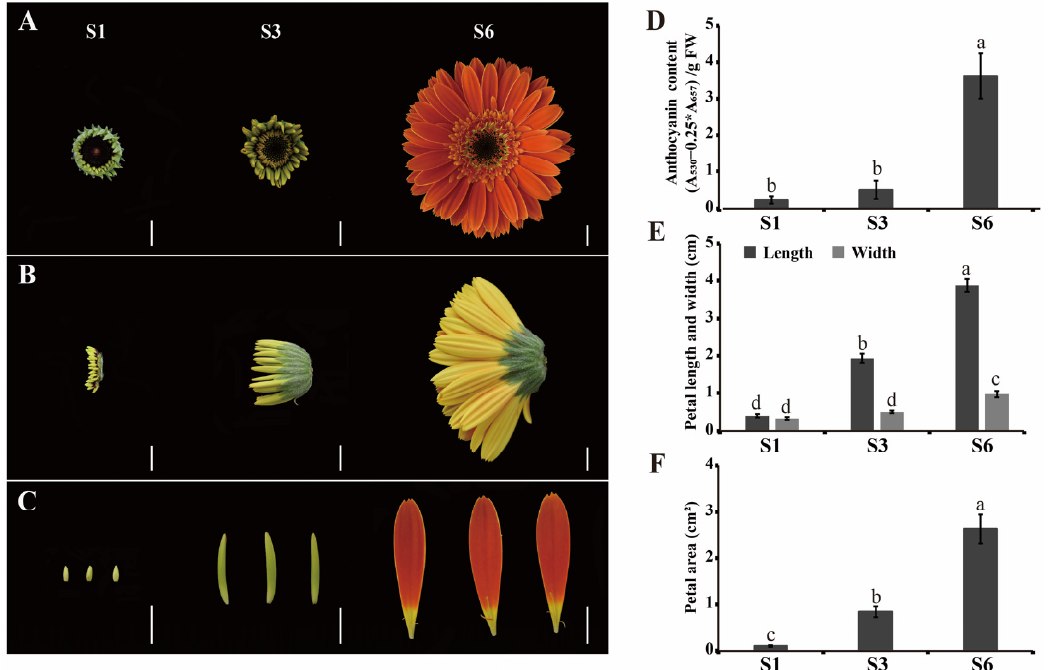
Figure 1. Morphological features of ray florets at different growth and development stages. ( A – C ), Front ( A ) and side ( B ) view of inflorescence, and ray florets ( C ) of gerbera at different stages. Scale bar = 1 cm. ( D – F ), The anthocyanin contents ( D ), length and width ( E ), and area ( F ) of ray petals at different stages. FW: fresh weight. Statistical significance is indicated by different letters ( p < 0.05). Values represent means of n = 3 ± SD.